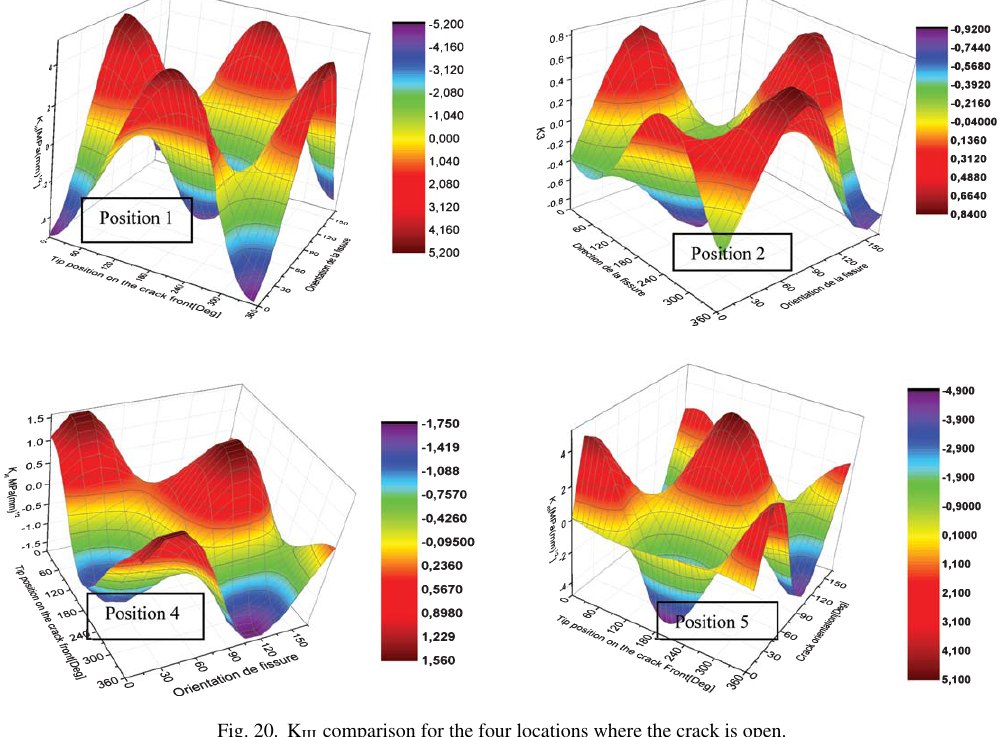
Fig. 20. K III comparison for the four locations where the crack is open.